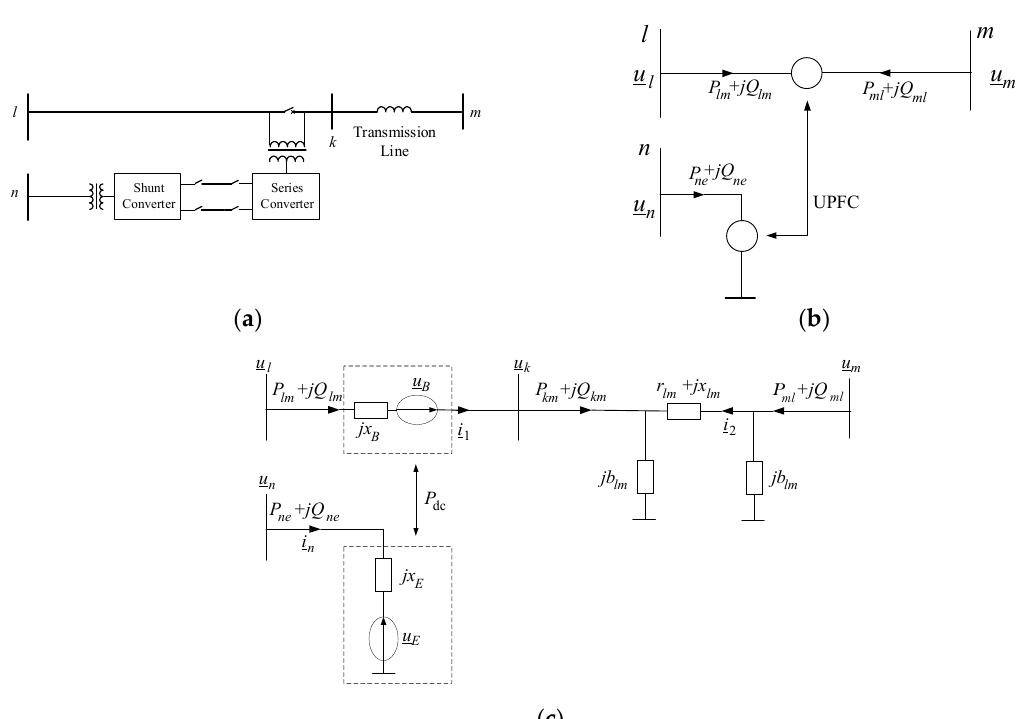
Figure 2. The general structure of UPFC and its equivalent model: ( a ) the general structure of UPFC; ( b ) the equivalent model of the general structure UPFC; ( c ) the equivalent circuit of the general structure UPFC.